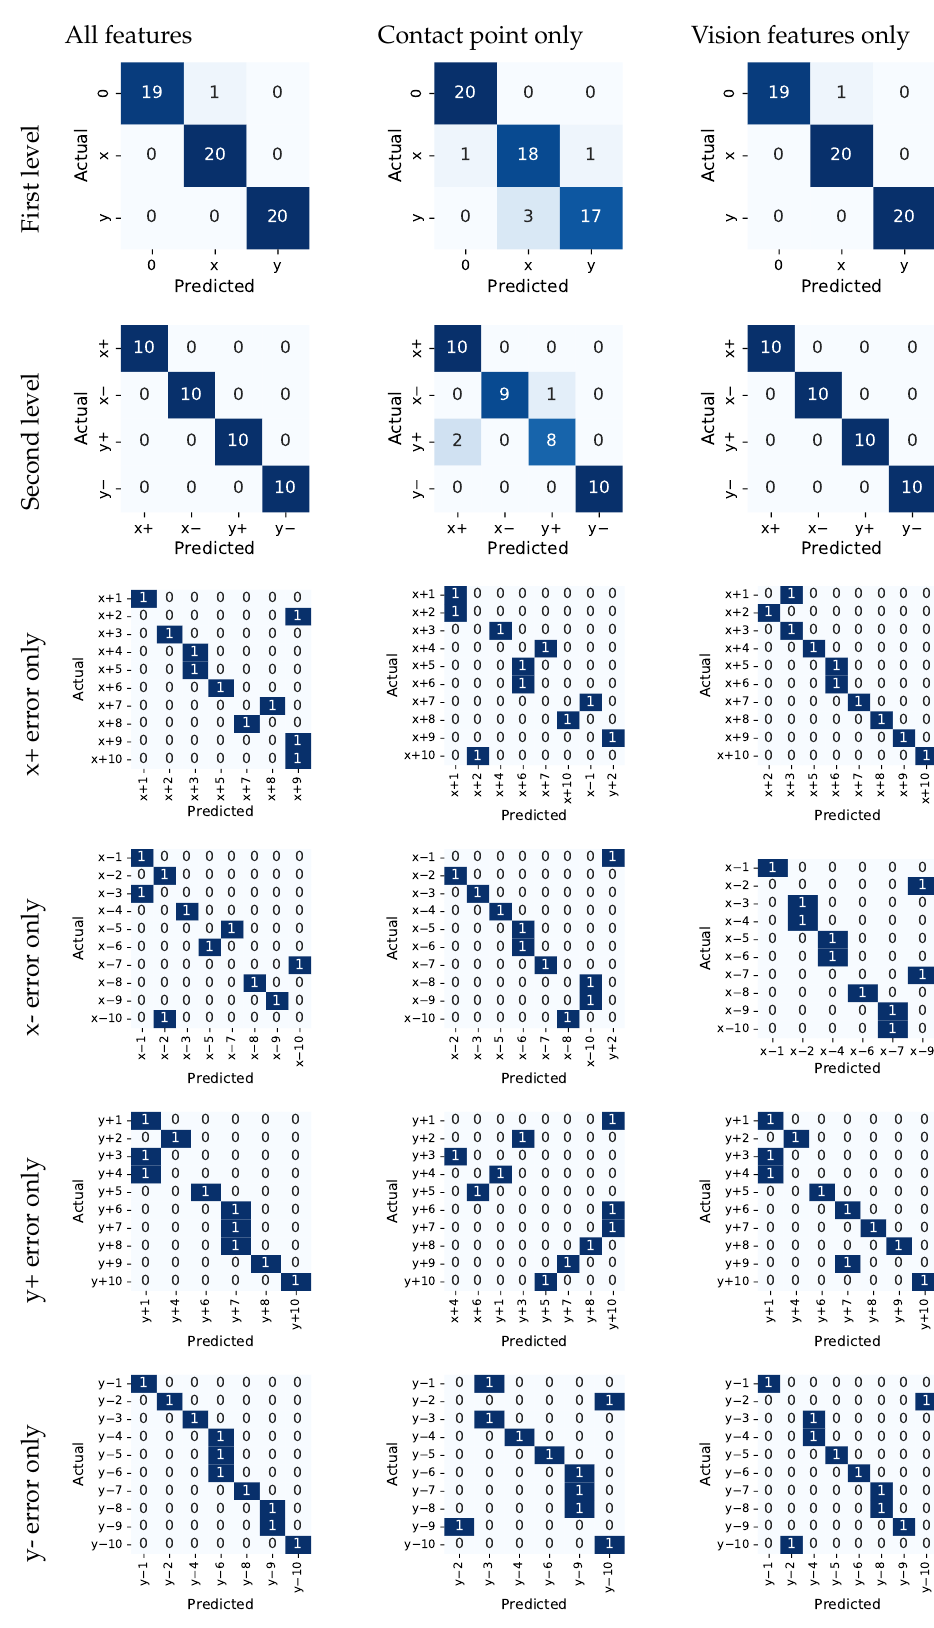
Figure 13. Confusion matrices for the PiH use